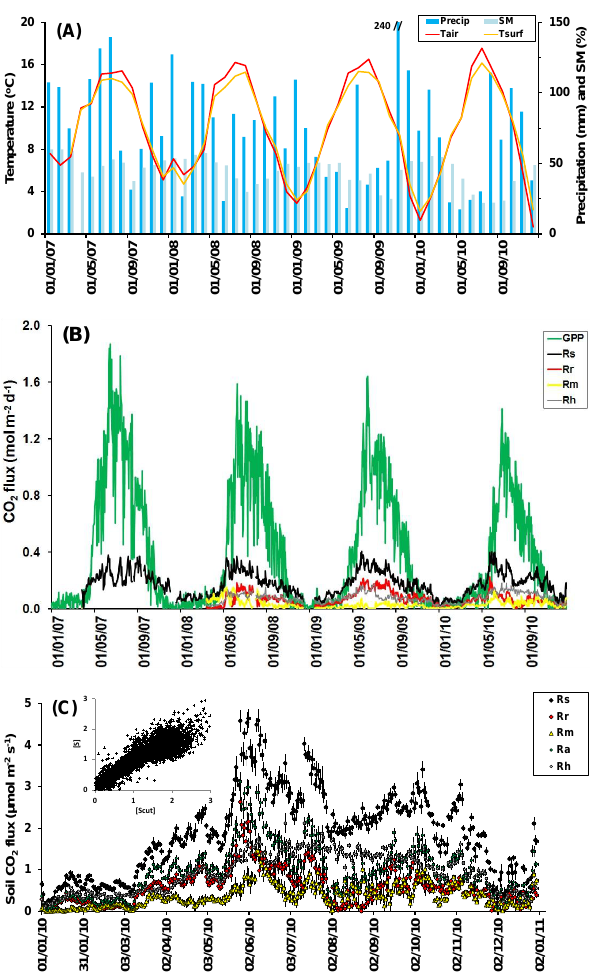
Fig. 3. (A) Monthly average air temperature (Tair), soil surface temperature (Tsurf), precipitation sum (Precip) and soil volumet- ric moisture content (SM) at the Straits Enclosure, Alice Holt for- est from 2007 to 2010. (B) Mean daily ecosystem CO 2 flux com- ponents (mol CO 2 m − 2 d − 1 ) during the same period, comprising gross primary productivity (GPP) and total soil respiration ( R s ) , and contributions from roots ( R r ) , mycorrhizal hyphae ( R m ) and het- erotrophic soil respiration ( R h ) . (C) Mean ( ± SE) daily soil CO 2 flux for total respiration ( R s ) and its components (i.e. root ( R r ) , mycorrhizal ( R m ) and heterotrophic ( R h ) flux) derived from hourly flux measurements during 2010 from the different treatment plots ( n = 4). R a is the sum of R r and R m . The inset shows the mean hourly fluxes of steel collar (S) versus repeatedly cut (S cut ) treat- ments.